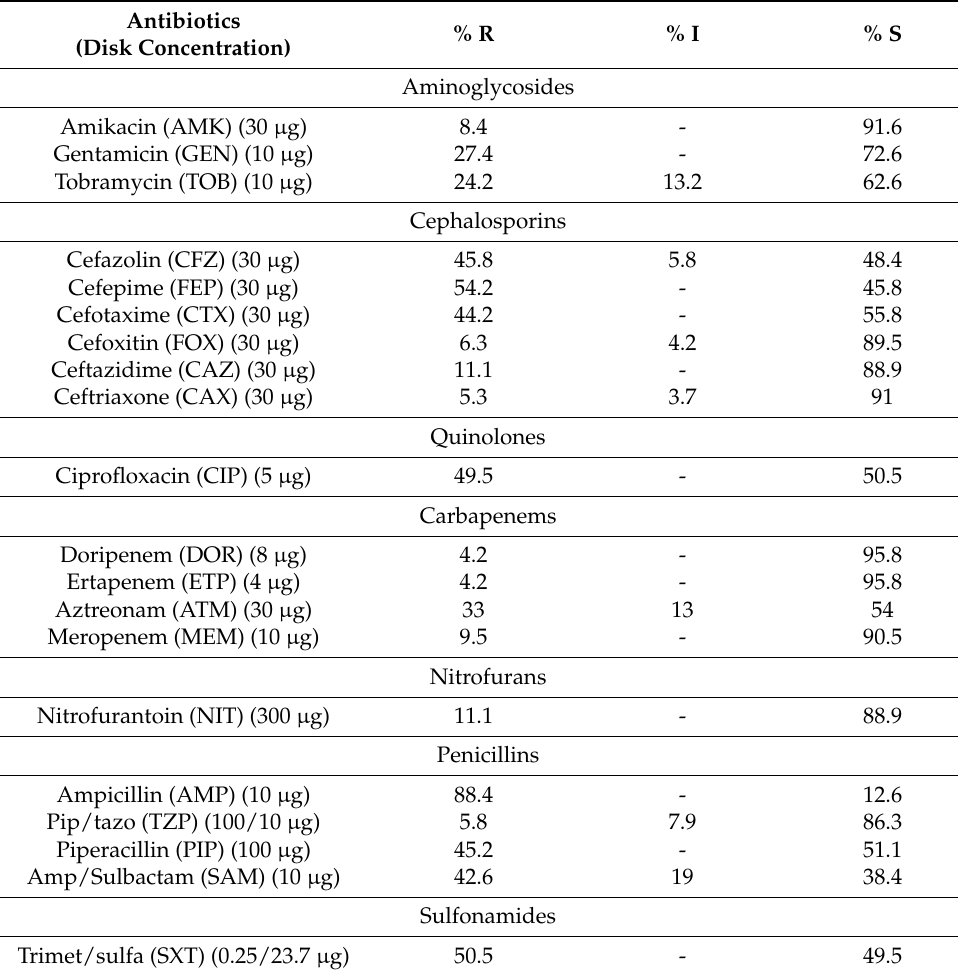
Table 2. Antimicrobial susceptibility pattern of isolated